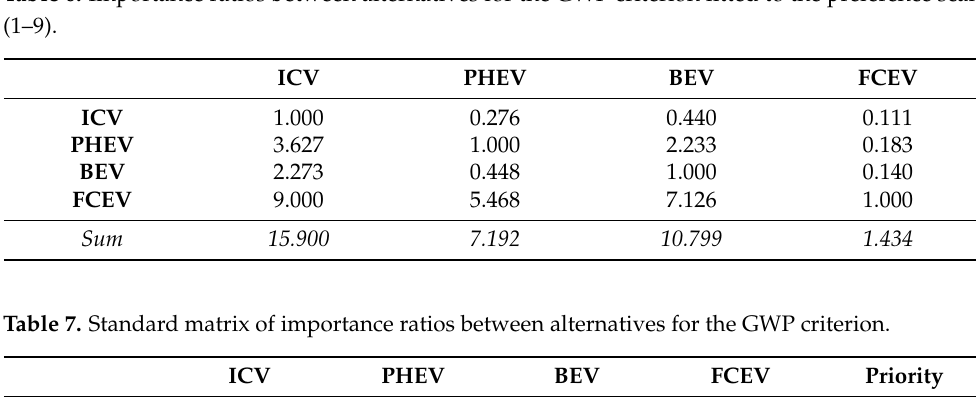
Table 5. Ratios between alternatives for the global warming potential (GWP) criterion from Table 3 values. ICV PHEV BEV FCEV ICV 1.000 0.832 0.911 0.619 PHEV 1.202 1.000 BEV